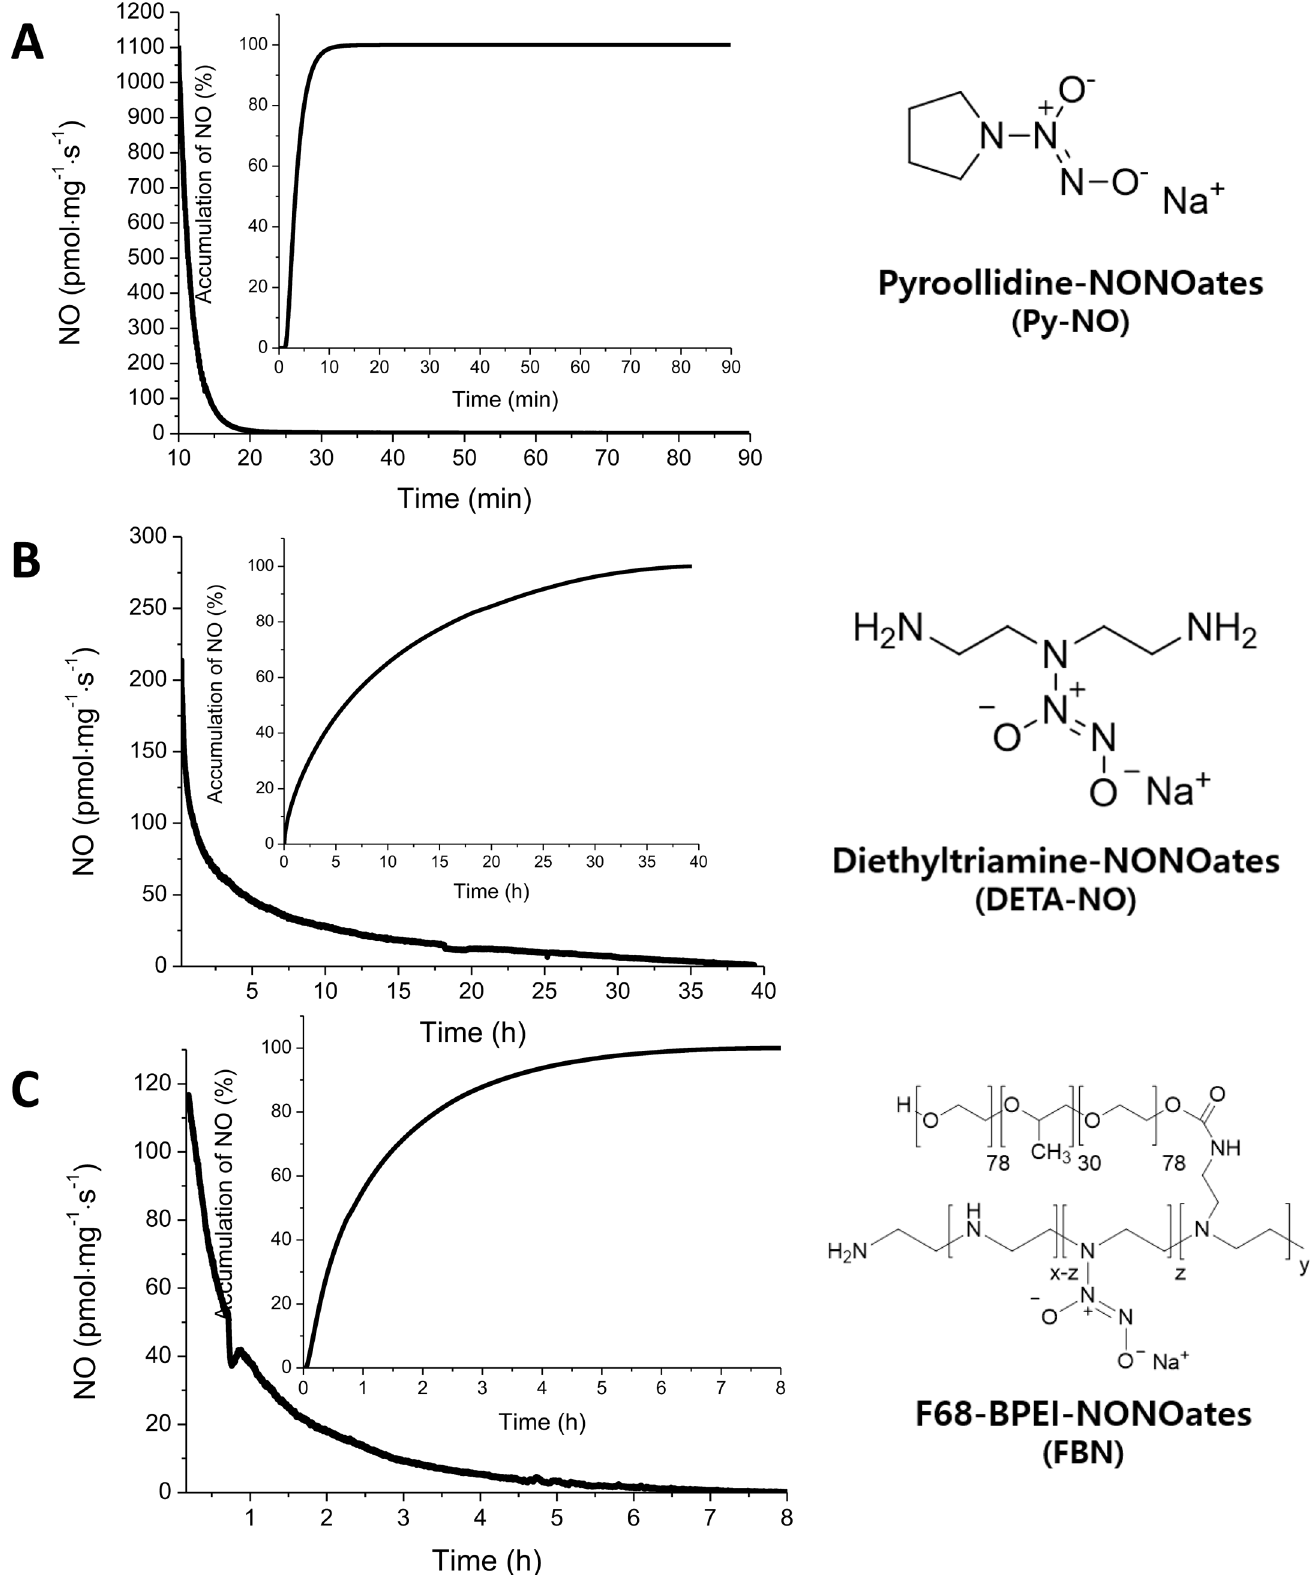
Fig 1. Characterization of NO-releasing compounds. “Time” indicates the time course after the bacteria or cells were exposed to NO. NO, nitric oxide.